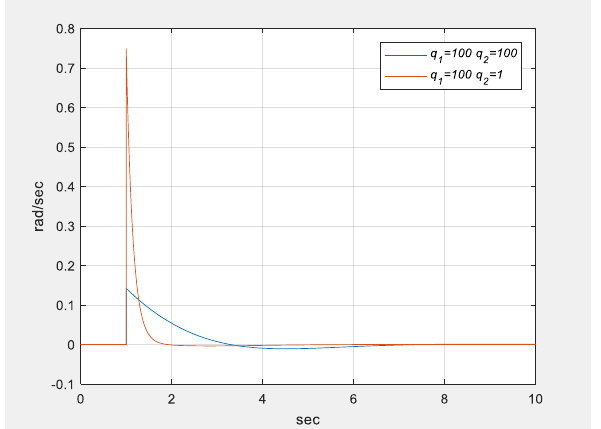
Figure 16. Verification of the influence of specific force tracking on angular velocity θ s . influence of β 1 on influence of influence of on